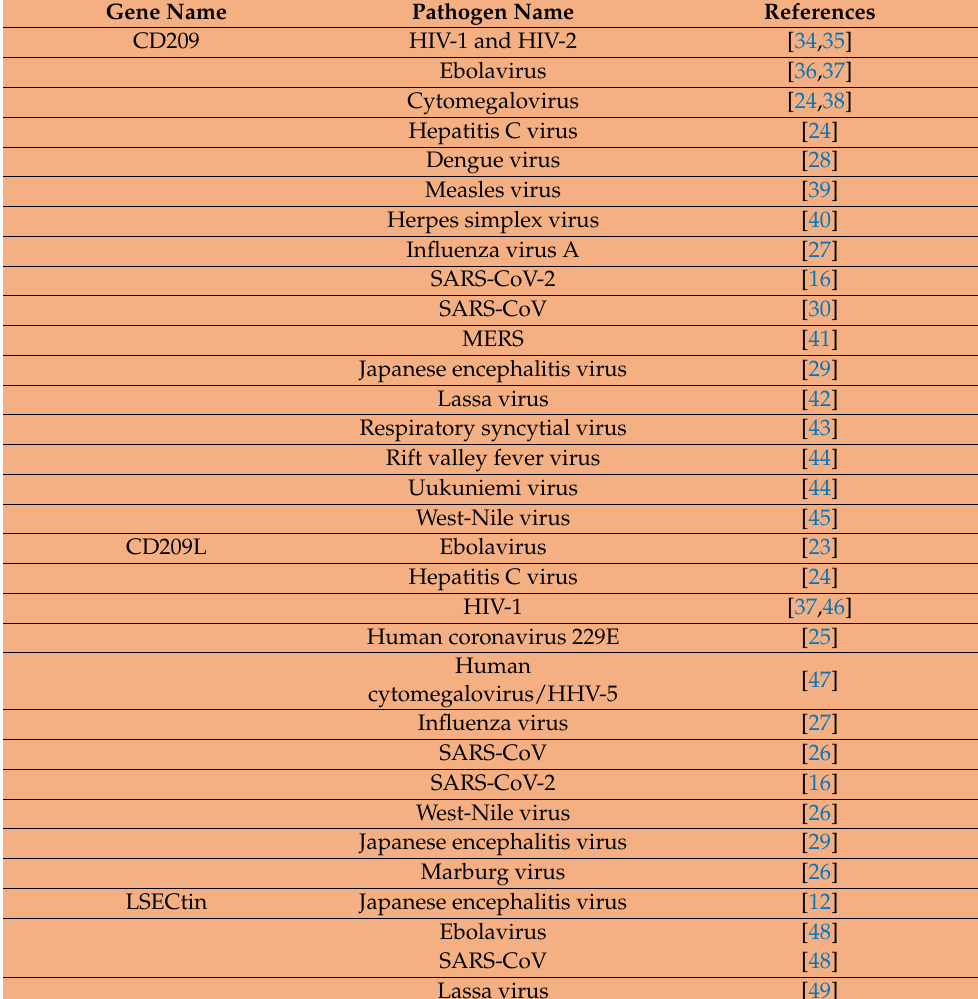
Table 1. List of known pathogens recognized by CD209, CD209L and LSECtin lectin family proteins. The data is extracted from the publications available through